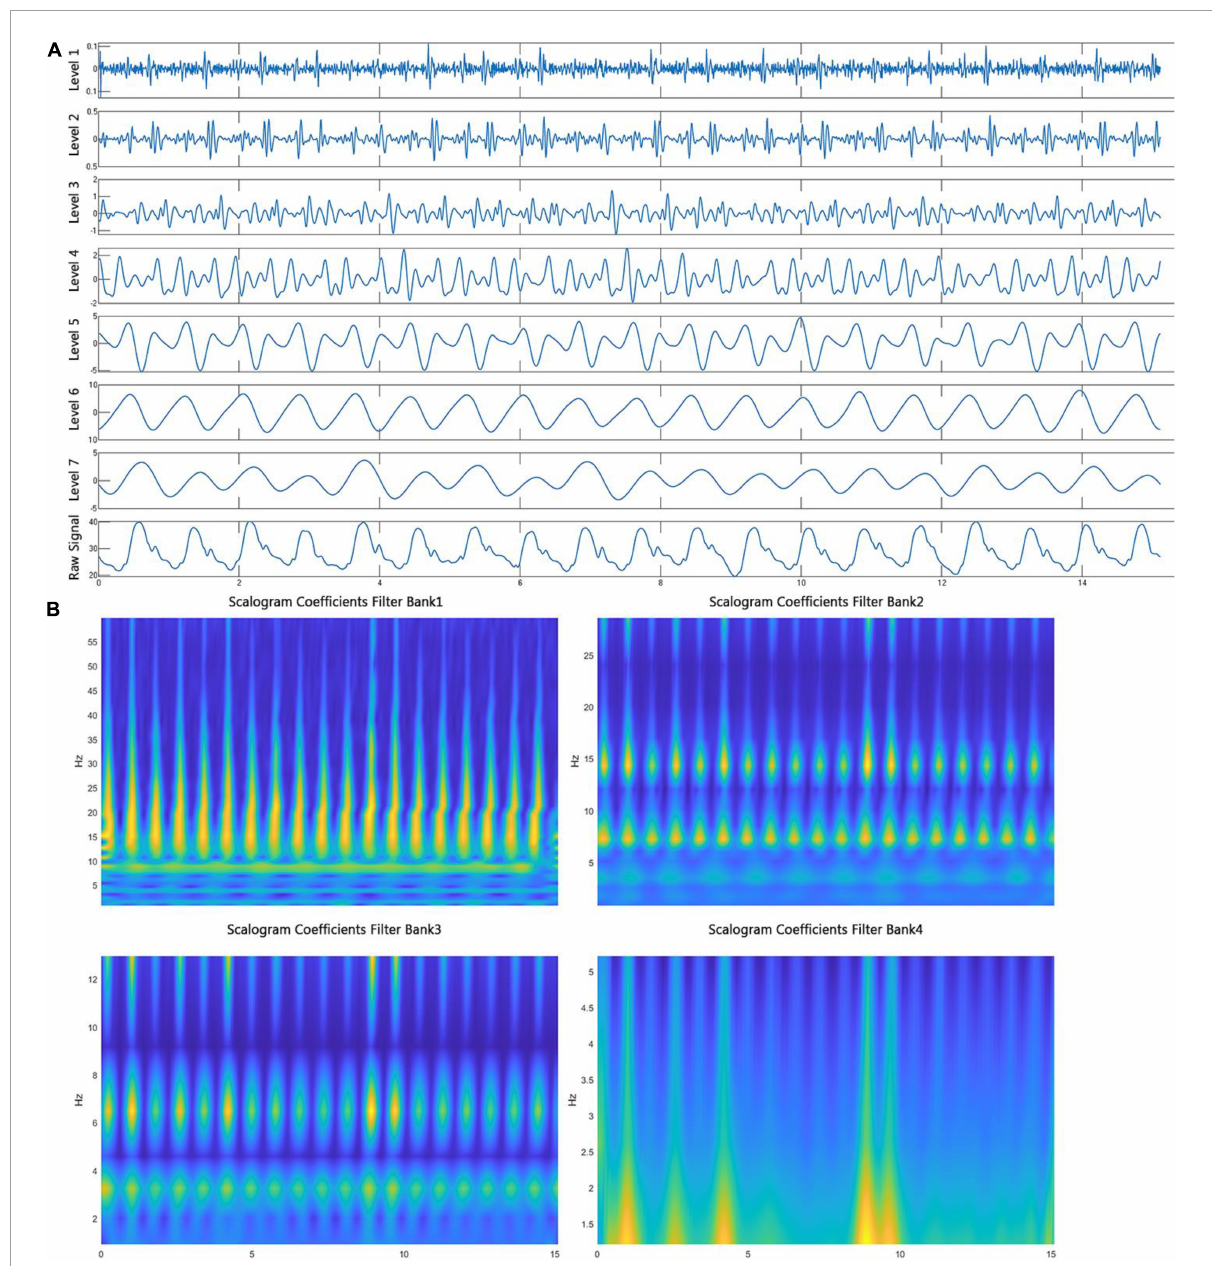
FIGURE3 Wavelet scattering transform and wavelet decomposition. (A) A segment of PAP signal was decomposed to seven level components by a symlet4 wavelet function, representing the frequency from high to low. (B) Four spectrumgrams present a segment of ECG signals after wavelet scattering transformation in which the four filter banks and the Gabor wavelet function were